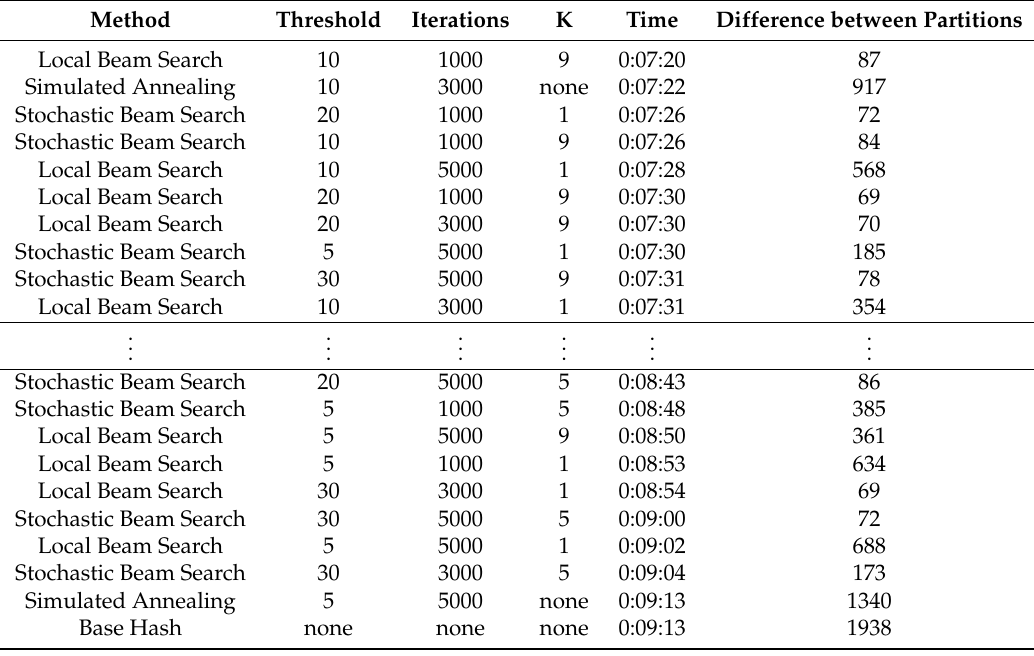
Table 3. The ten best and ten worst time